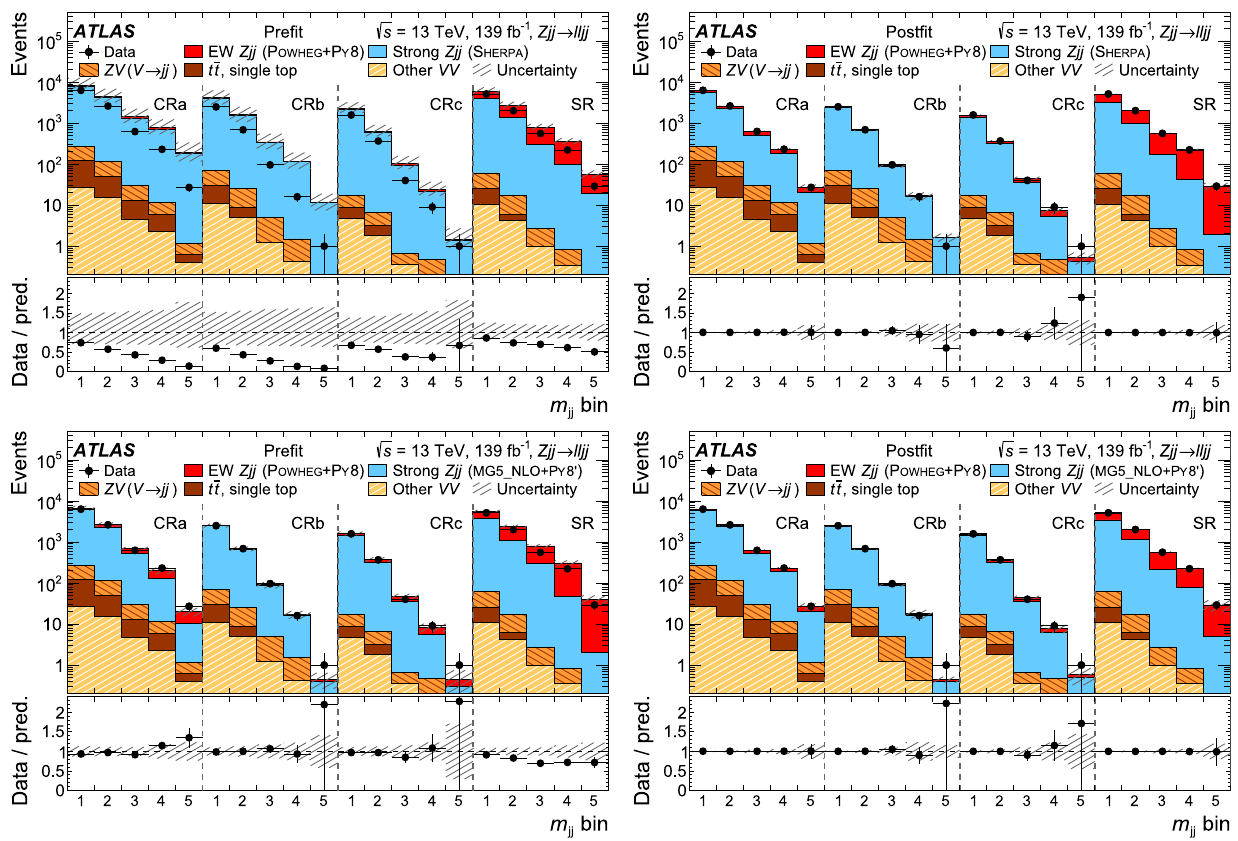
Fig. 5 Comparison between data and prediction before (left) and after (right) the fit using strong Zjj estimates based on Sherpa (top) and MG5_NLO+P y 8’ (bottom) in bins of m jj in the different control and signal regions. The MG5_NLO+P y 8’ prediction is obtained by a particle- level reweighting of the strong Zjj simulation provided by MG5+P y 8. The m jj bin edges are defined by ( 1 . 0 , 1 . 5 , 2 . 25 , 3 . 0 , 4 . 5 , 7 . 5 )